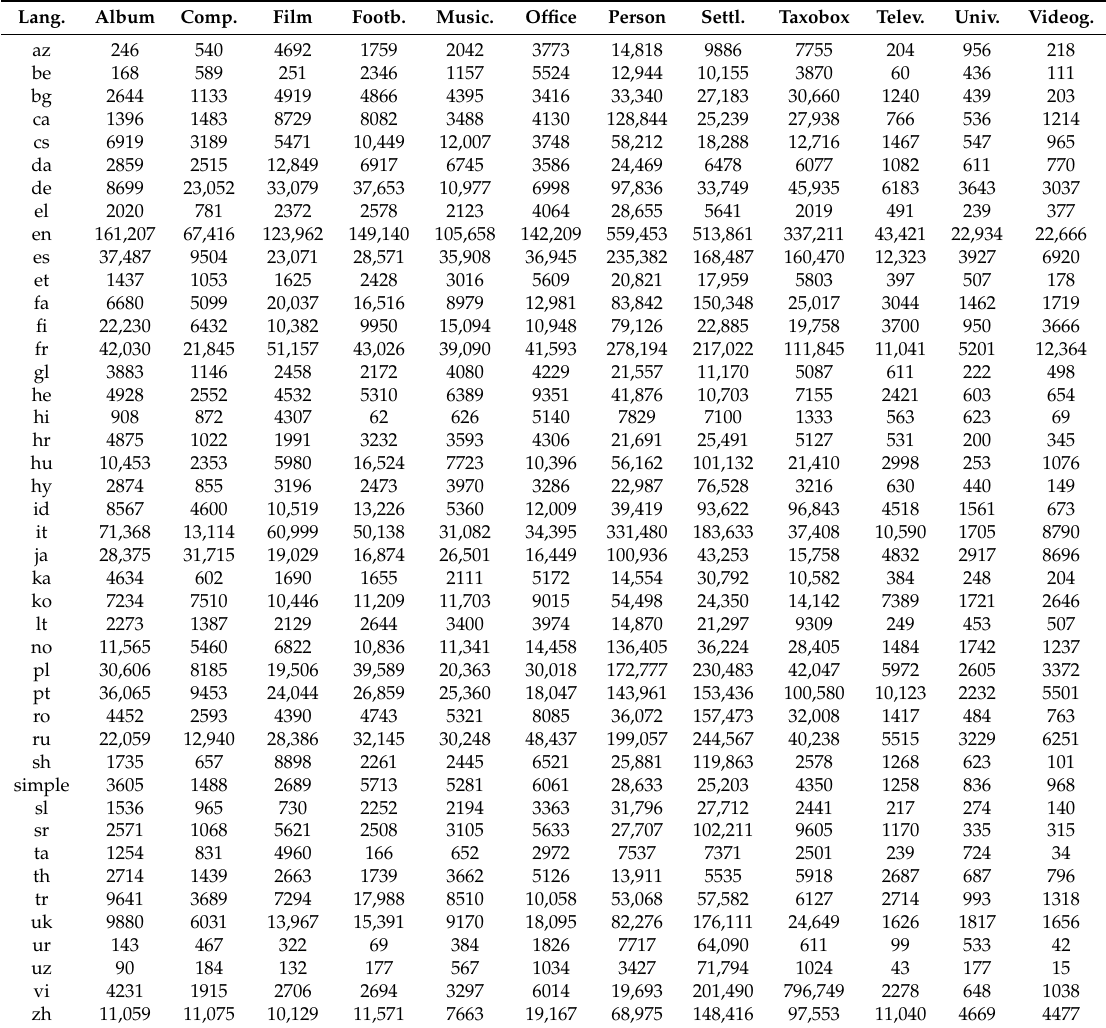
Table 5. Number of articles on particular topic in various Wikipedia languages. Source: own calculations. Lang. Album